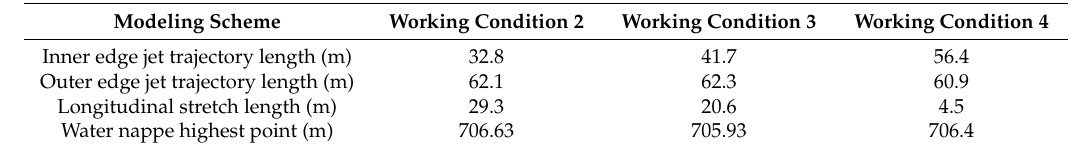
Figure 16. Inner and outer edges of the water nappe under different working conditions. Table 6. Analysis of the water nappe features under different working conditions of the swallow-tailed bucket scheme II.